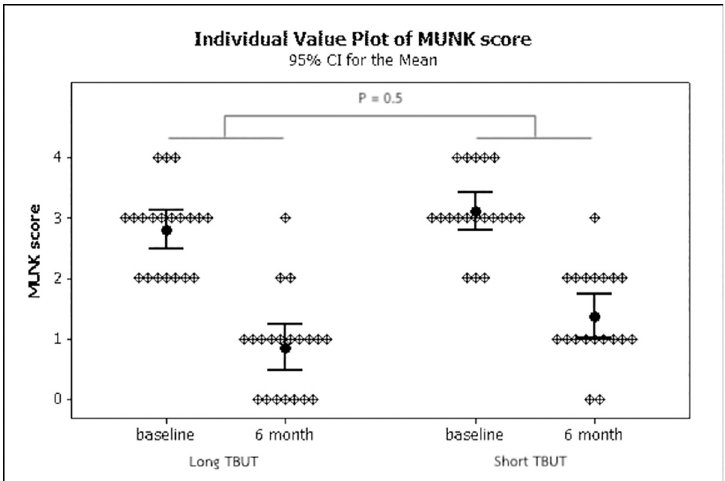
Fig 2. Individual value plot of MUNK score for long tear breakup time and short tear breakup time (black circle dot indicates mean; line indicates 95% confidence interval of the mean).